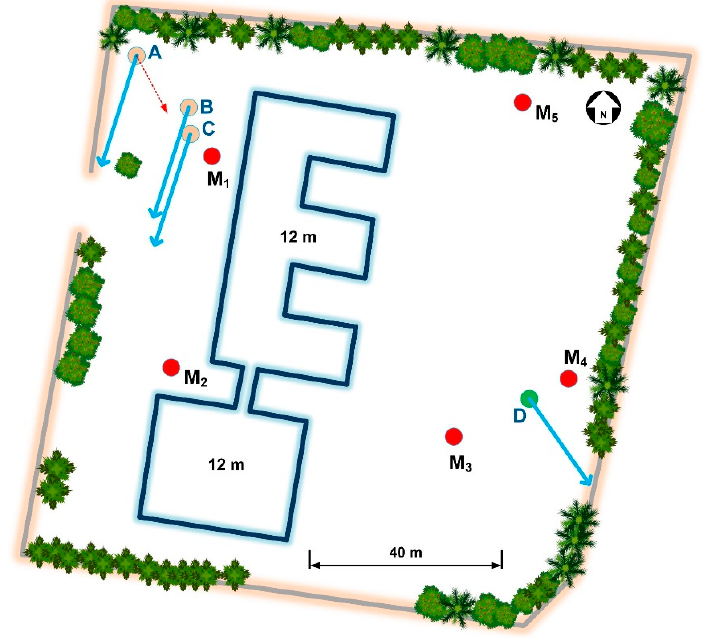
Figure 9. Ground plan of the teleport facilities where a real interference scenario is assessed. Table 1. Technical Parameters of the Ground Stations for the Interference Assessment.